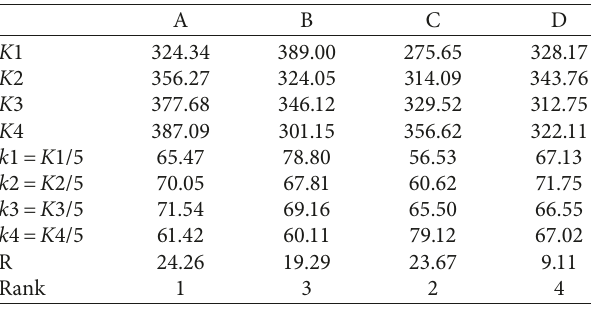
Figure 5: Influence trend of factors on the maximum thinning rate at different levels. Table 5: Influence of various factors on maximum thickening rate.